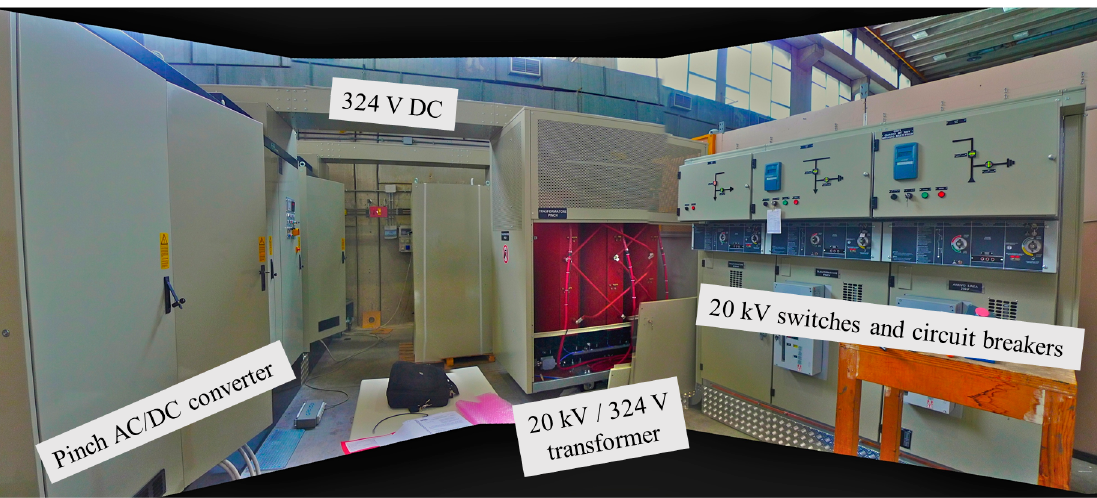
( b ) Figure 11. ( a ) Voltage measured in three phases of the cathode power supply during a voltage ramp; ( b ) Photo of the cathode taken during the heating phase. 4.5. Pinch Power Supply The pinch and PFC power supply systems are located in a segregated cubicle of the PROTO ‐ SPHERA hall, as shown in Figure 12. Both the systems are based on a 12 ‐ pulse AC/DC converter implemented by two parallel thyristor bridges fed by a 20 kV/324 V transformer with two secondary (delta and star) windings. The two converter transformers are dry ‐ type for indoor installation. The scope of the pinch power supply is to generate and maintain the arc between the electrodes. Its converter current controller is regulated to reach the desired flat ‐ top in the minimum possible